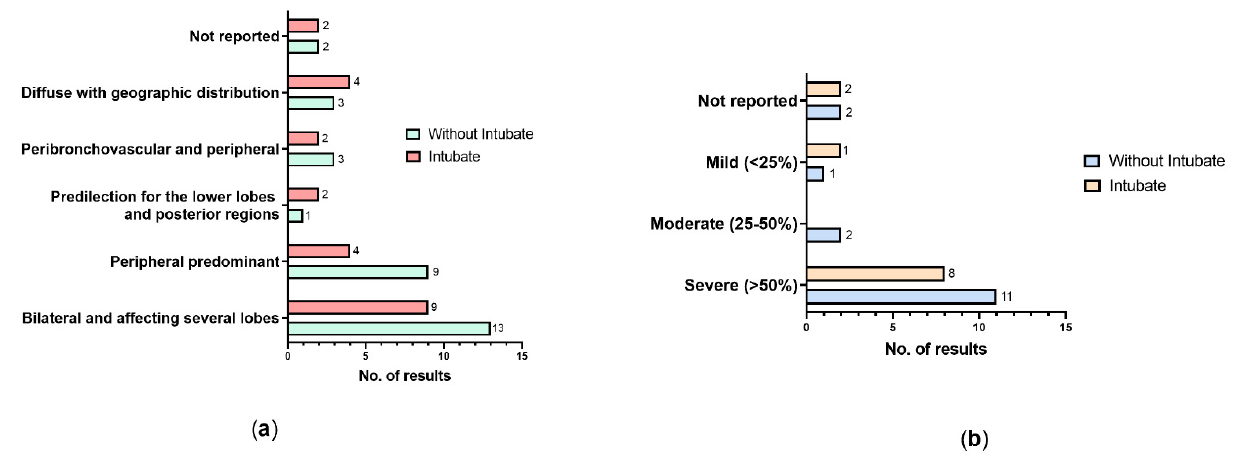
Figure 7. Patterns of lesion distributions and the level of lung involvement found in imaging exams (CT scan and chest X-ray) before using the device: ( a ) pattern of lesion distribution among patients who needed or who did not need mechanical ventilation required intubation and ( b ) level of pulmonary impairment among patients who needed or who did not need mechanical ventilation.